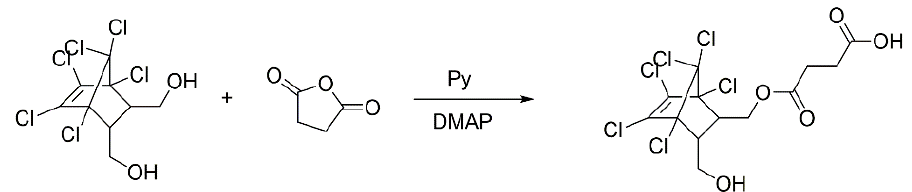
Figure 1. Synthesis of the endosulfan